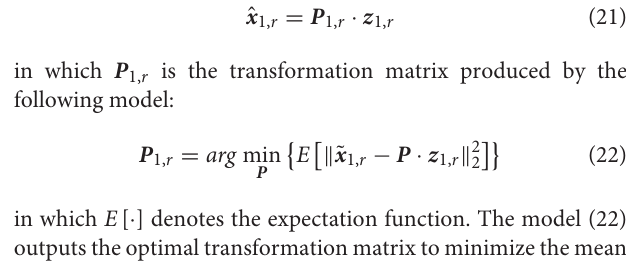
Frontiers in Plant Science |